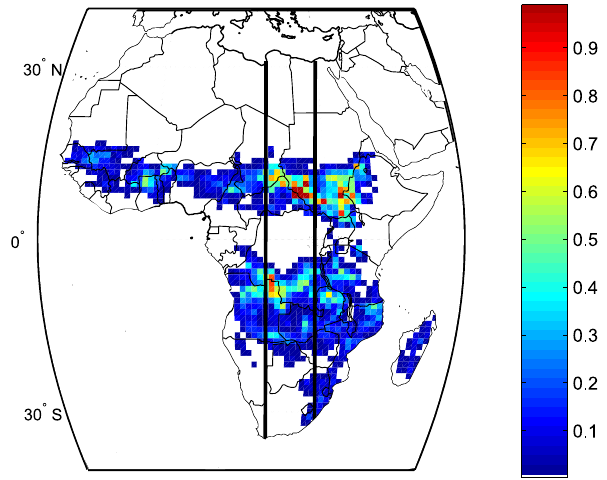
Fig. 1. Mean annual fraction of area burned, averaged over all inves- tigated years from 2000–2007. Data from grid cells located outside the two bold meridian lines were used as training data to estimate the model parameters (except for the data for the year 2007). The data from grid cells between the two meridians were only used to estimate the